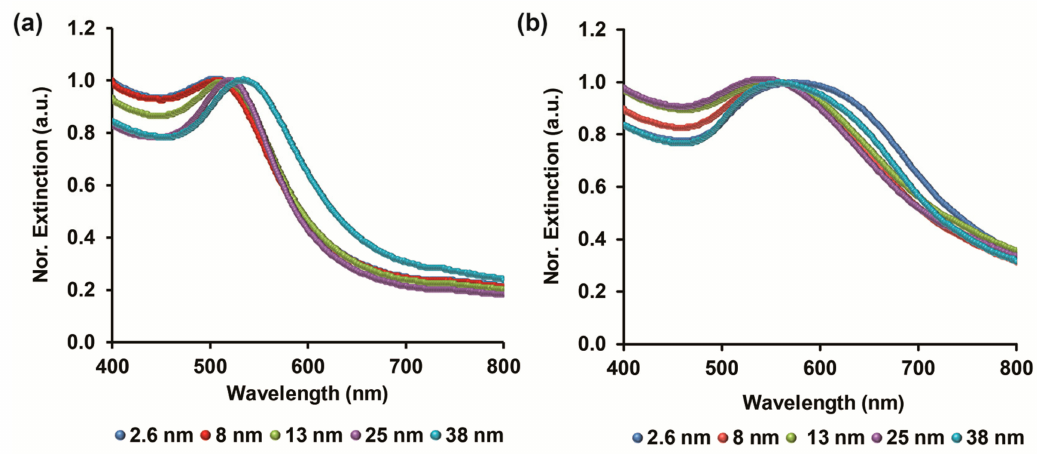
Figure 2. Normalized UV–VIS extinction spectra of the di ff erent GNPs sizes: ( a ) Before and ( b ) after PDT